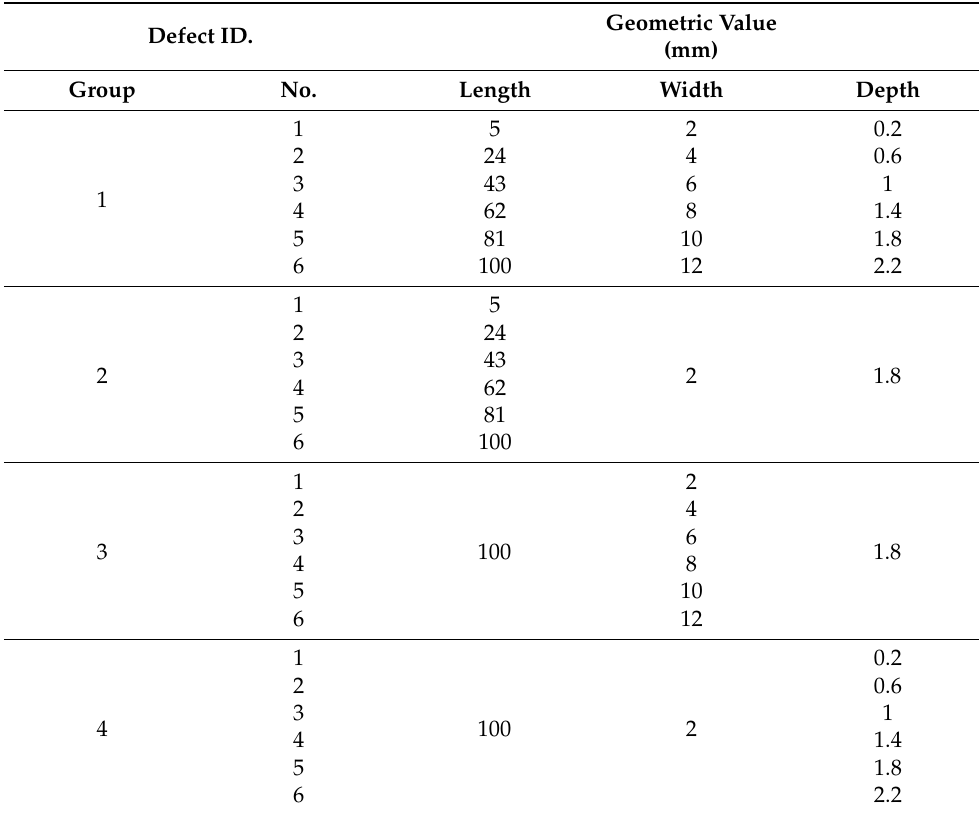
Table 1. Classification of each defect and its dimensional value.